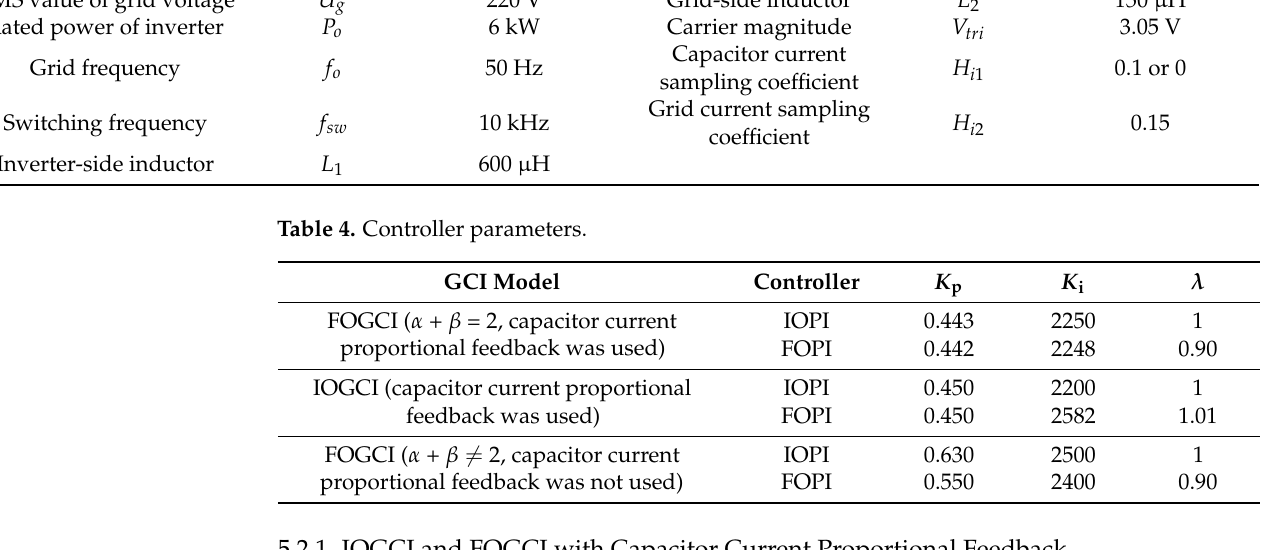
15 of 20 15 of 20